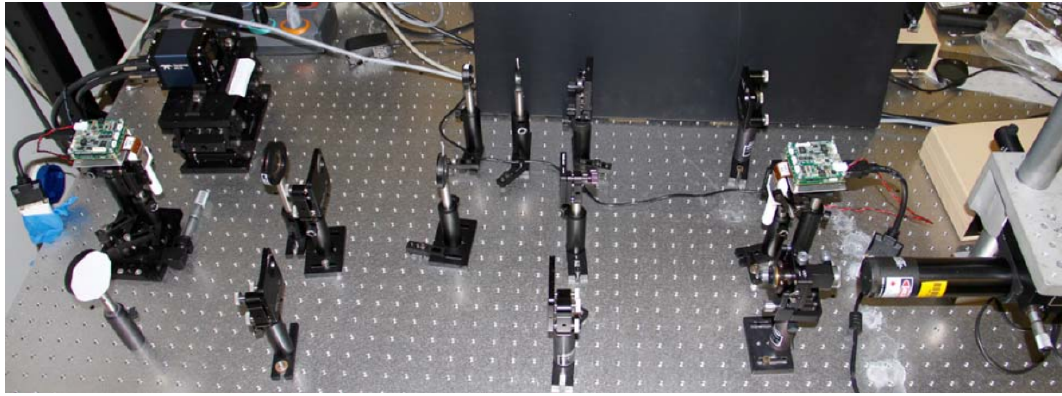
Figure 1. Bench setup for free-space